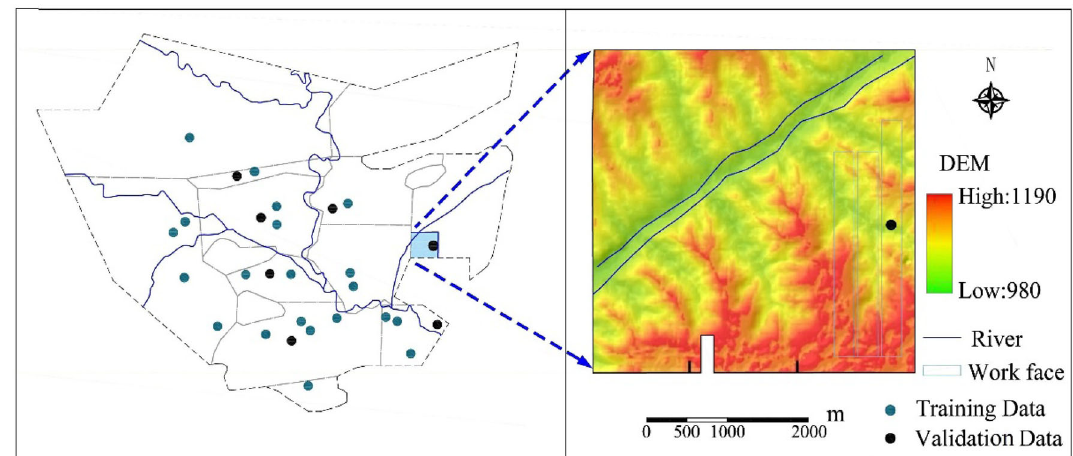
Fig. 6 Location of the first mining area in the Wenjiapo coal mine